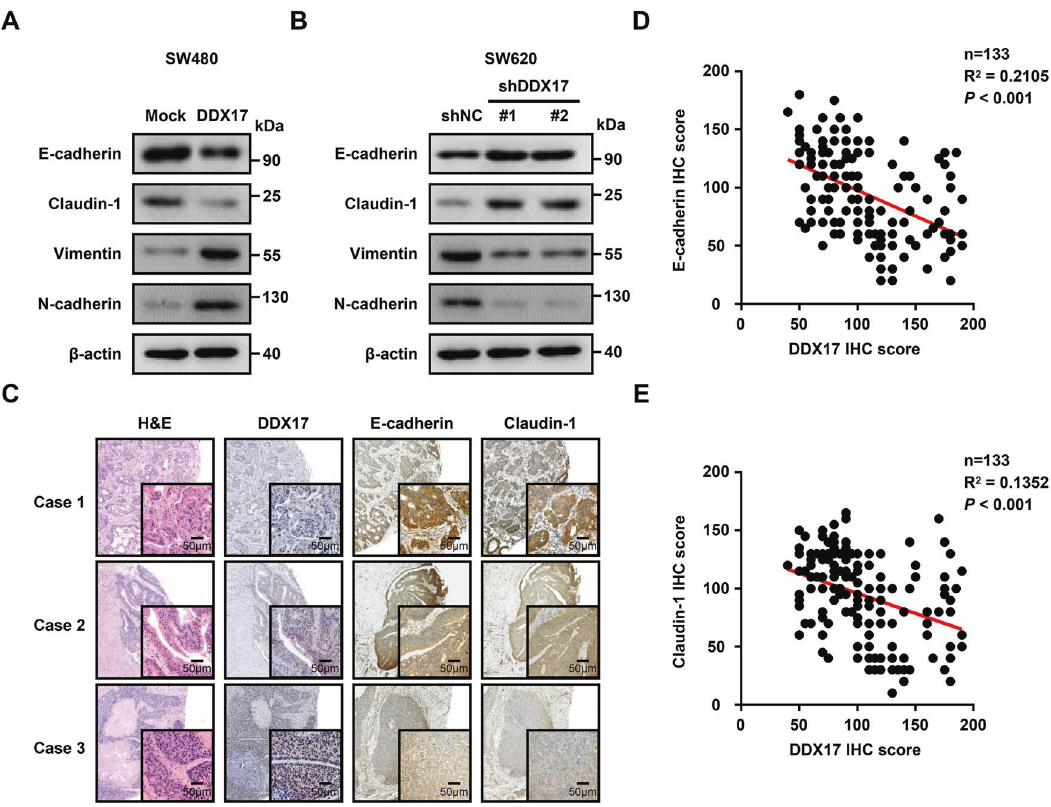
Fig. 3 DDX17 induces EMT progression in CRC. A Western blot analysis of EMT marker expression in DDX17-overexpressing and mock SW480 cells. B Western blot analysis of EMT marker expression in DDX17-de fi cient and control SW620 cells. C Representative immunohistochemical staining images of DDX17, E-cadherin, and Claudin-1 levels in CRC tissues. D Correlation analysis between the protein expressions of DDX17 and E-cadherin in CRC tissues. E Correlation analysis between the protein expressions of DDX17 and claudin-1 in CRC